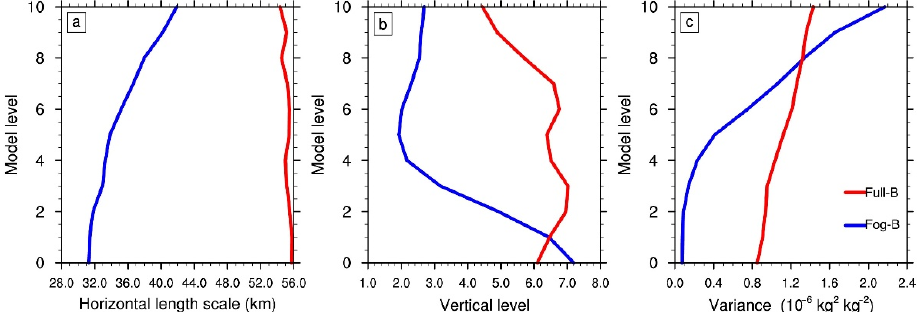
Figure 6. ( a ) Horizontal length scales (km), ( b ) vertical length scales (vertical grid), and ( c ) variance (kg 2 kg − 2 ) as a function of model level for q estimated over the entire computational domain (Full- B ; red lines) and the bin of P f (Fog- B ; blue lines). The error statistics computed from the bin of P f are used to represent Fog- B here. That is because only these error statistics of the feature-dependent B can directly affect the assimilation of satellite-derived humidity, since the satellite-derived humidity is assimilated only where the observed fog is missed in the